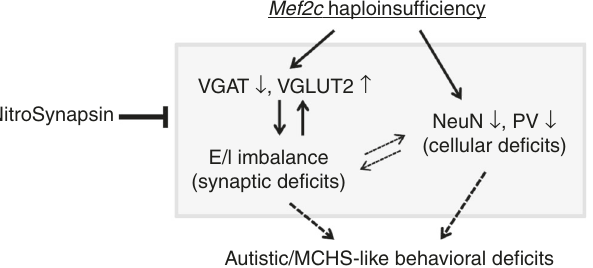
Fig. 8 Summary diagram of Mef2c haploinsuf fi ciency leading to E/I imbalance and MCHS-like phenotypes that are rescued by NitroSynapsin. Mef2c haploinsuf fi ciency leads to decreased VGAT and increased VGLUT2 protein levels, resulting in E/I imbalance (overexcitability) and synaptic dysfunction. Mef2c haploinsuf fi ciency also causes neuronal loss, notably a reduced number of PV+ inhibitory interneurons. These synaptic and cellular abnormalities are likely the underlying cause of the MCHS-like behavioral phenotypes observed in Mef2c -het mice. The histological and behavioral phenotypes are ameliorated by chronic treatment with